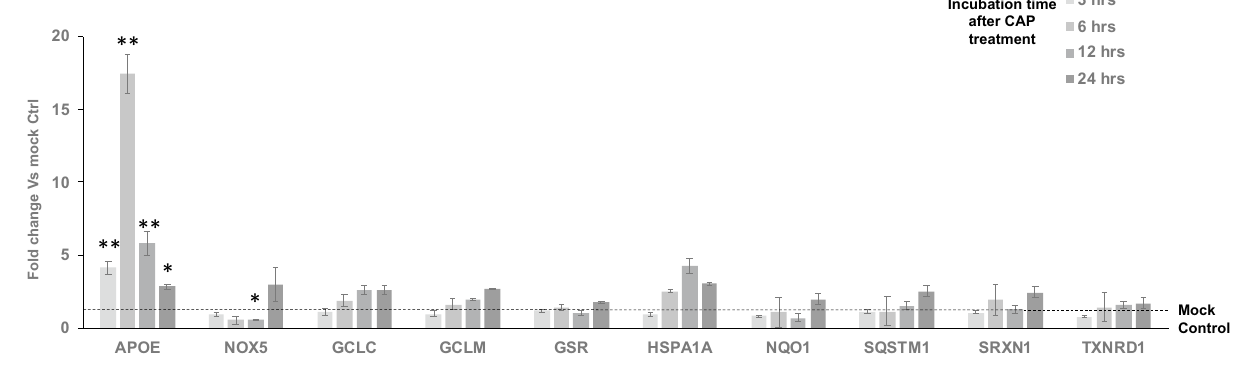
Figure 4. The regulation of oxidative stress genes APOE was differentially expressed after CHCP treatment. Bar graph showing the differential gene expression of genes involved in the regulation of oxidative stress after CAP treatment in TNBC cell line MDA-MB-231. The samples were normalized to 18s rRNA and the fold changes were compared to mock controls. Error bars represent means ± SEM. Student t test significant at *p values < 0.05, *p values <